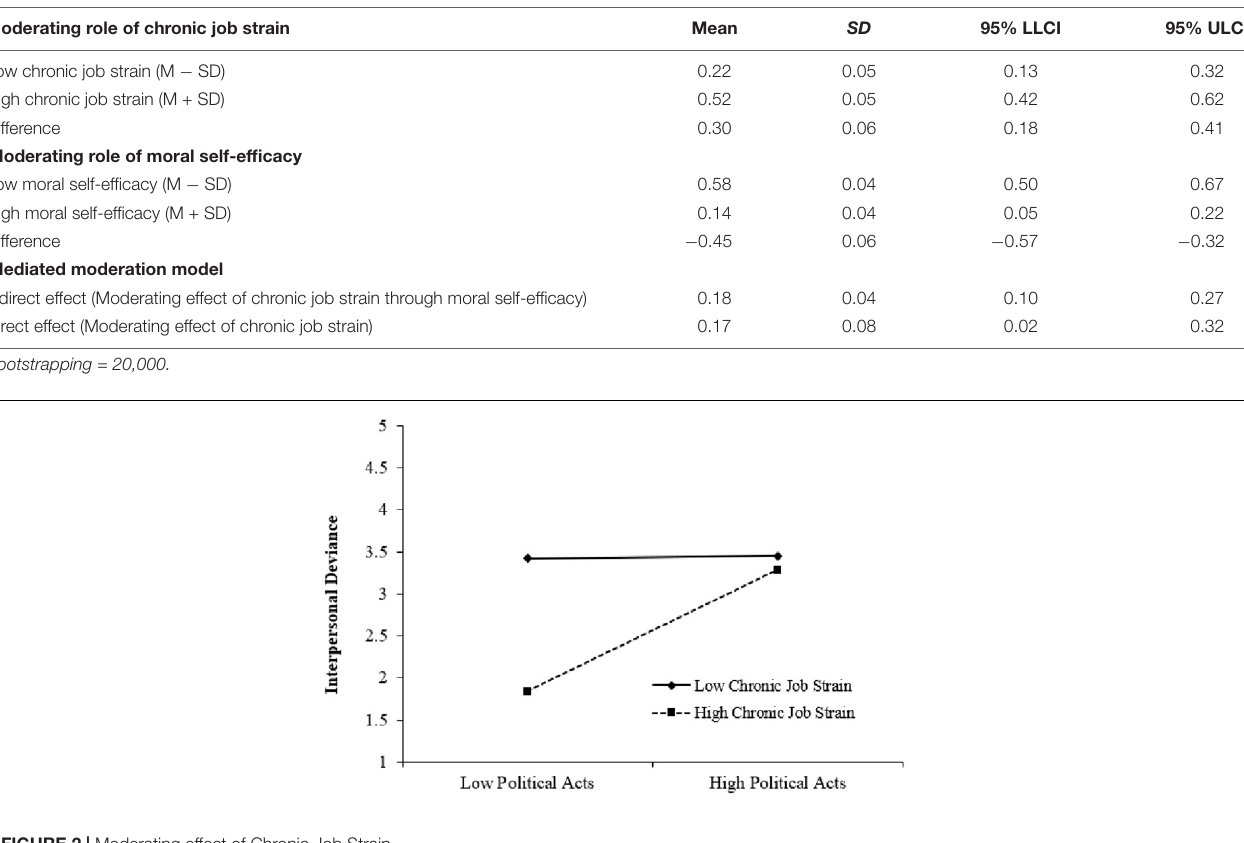
TABLE 3 | Results of Monte Carlo bootstrapping test.